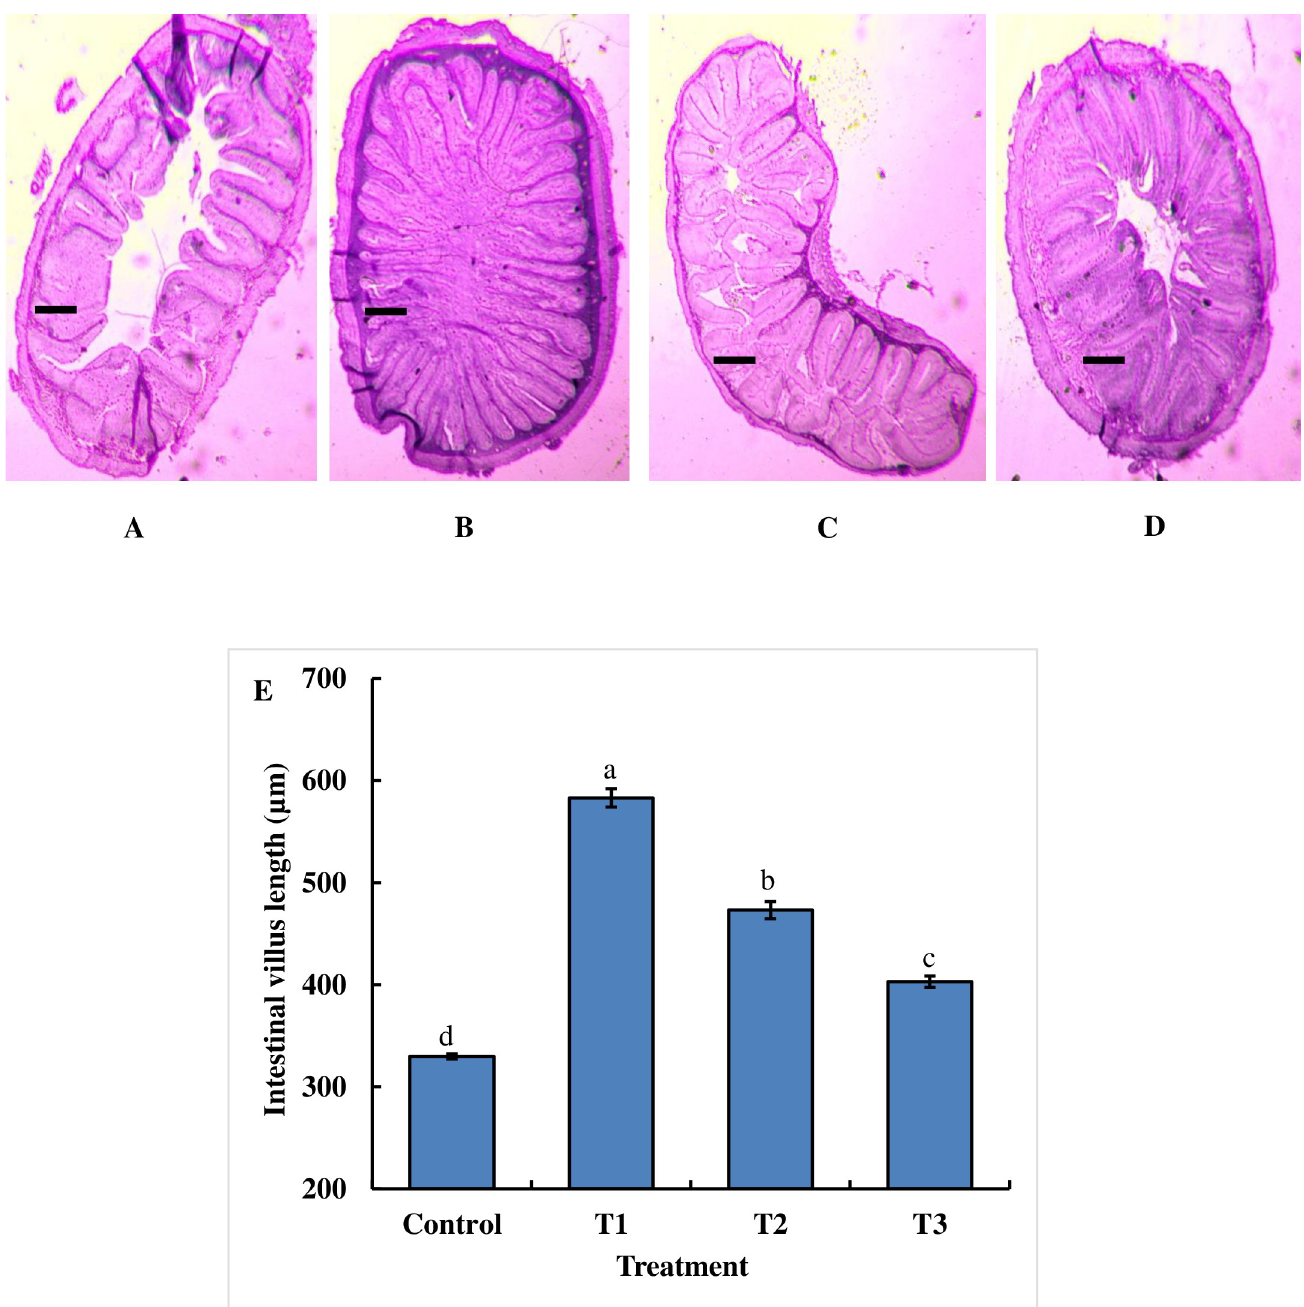
Fig 1. Histological analysis of the effects of dietary chitosan on villus length in the intestine of B . gonionotus (A-E). Fish were fed a (A) the control diet (0 g kg -1 feed), (B) T1 (1 g kg -1 feed), (C) T2 (2 g kg -1 feed) or (D) T3 (3 g kg -1 feed). (E) Dietary chitosan-treated intestinal villus length compared to that with the control is shown (n = 9). Different letter bars indicate significant variations in the intestinal villus length of fish (E) in different dietary chitosan groups at P < 0.05 (Statistix 10). Scale bar = 100 μ m; image 4x; H & E 200.